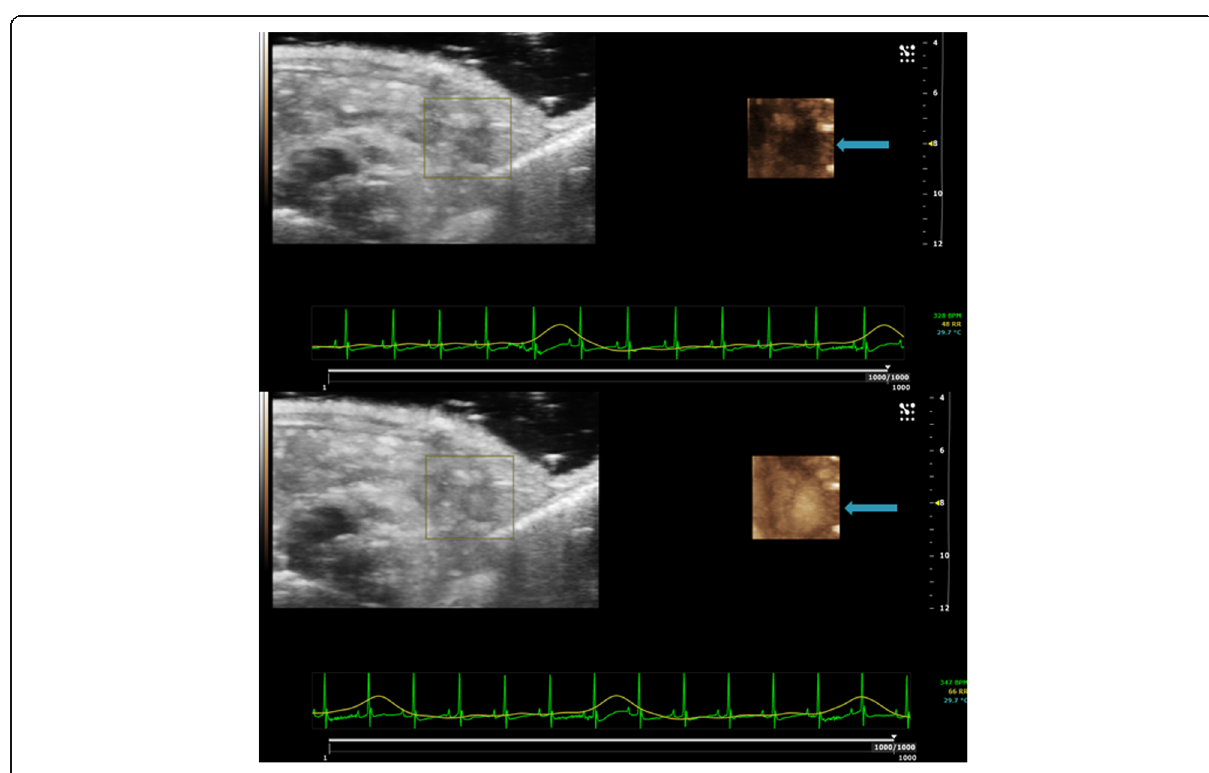
Fig. 2 CEUS dynamic acquisition using a side-by-side visualisation (see text) shows the hypoechoic ovary becoming progressively hyperechoic due to the contrast enhancement ( arrows